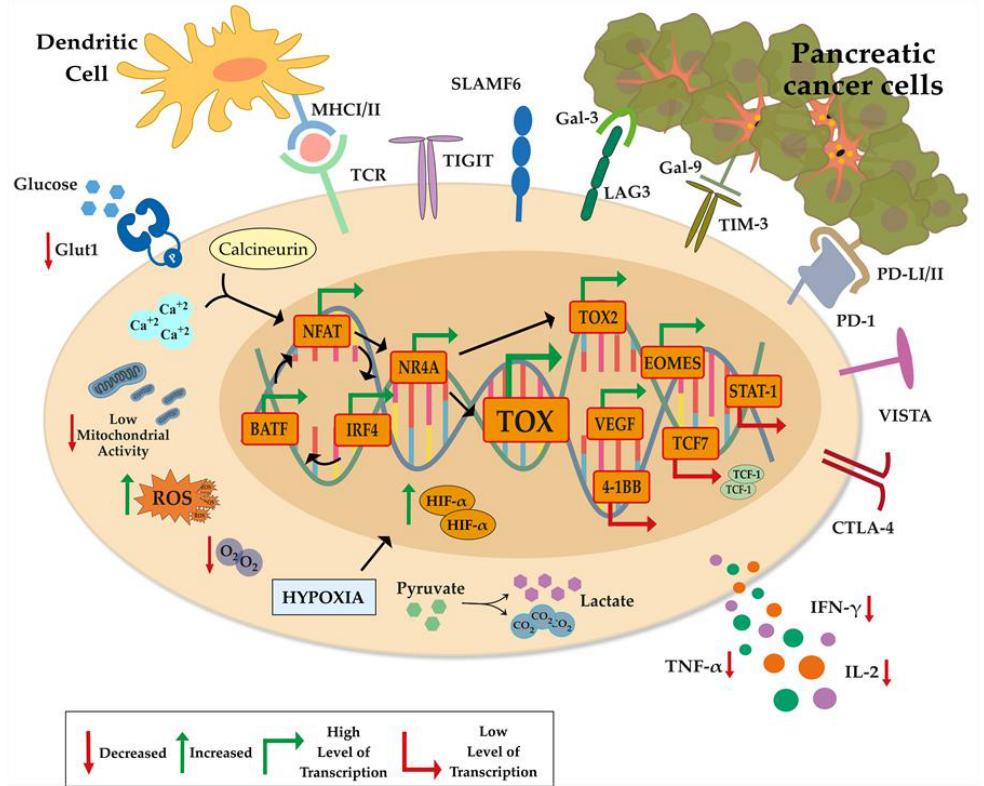
Figure 2. Epigenetic and transcriptional reprogramming in an exhausted T cell. Exhausted T cells have many immune checkpoints (CTLA-4, PD-1, LAG-3, TIM-3, TIGIT, SLAMF6, and VISTA) that are directly